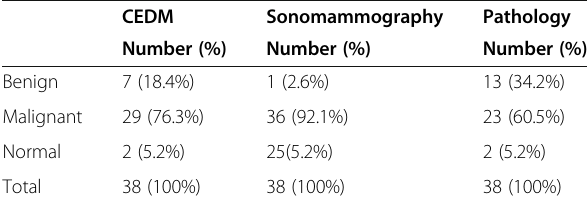
Table 2 CEDM, sonomammography, and pathology frequencies and percent